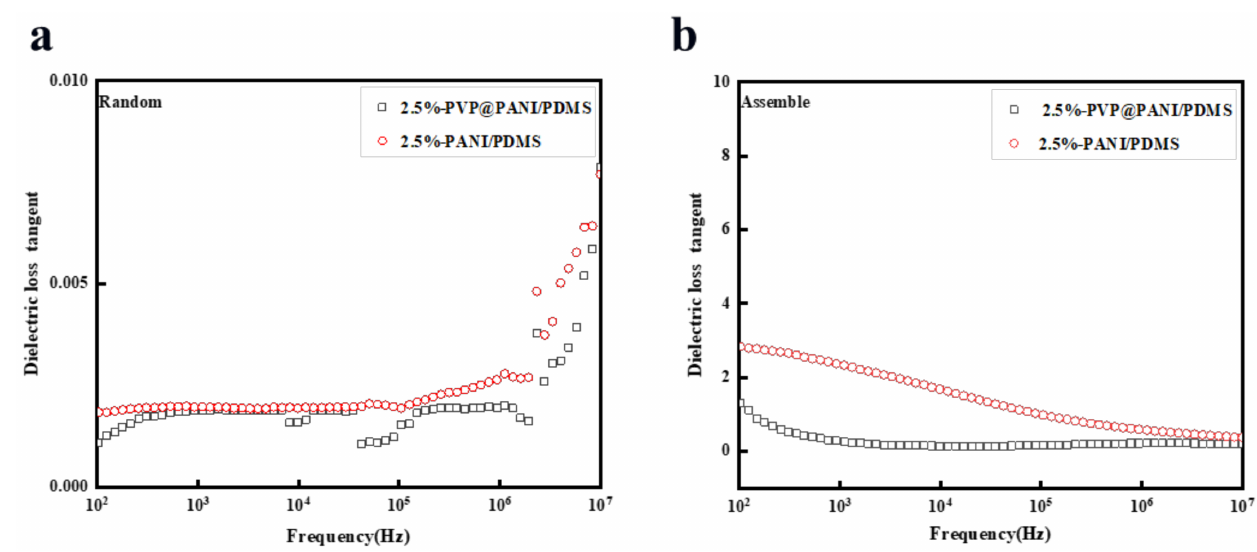
Figure 6. Dielectric loss tangent of ( a ) random PVP@PANI/PDMS and PANI/PDMS composites, ( b ) assembled